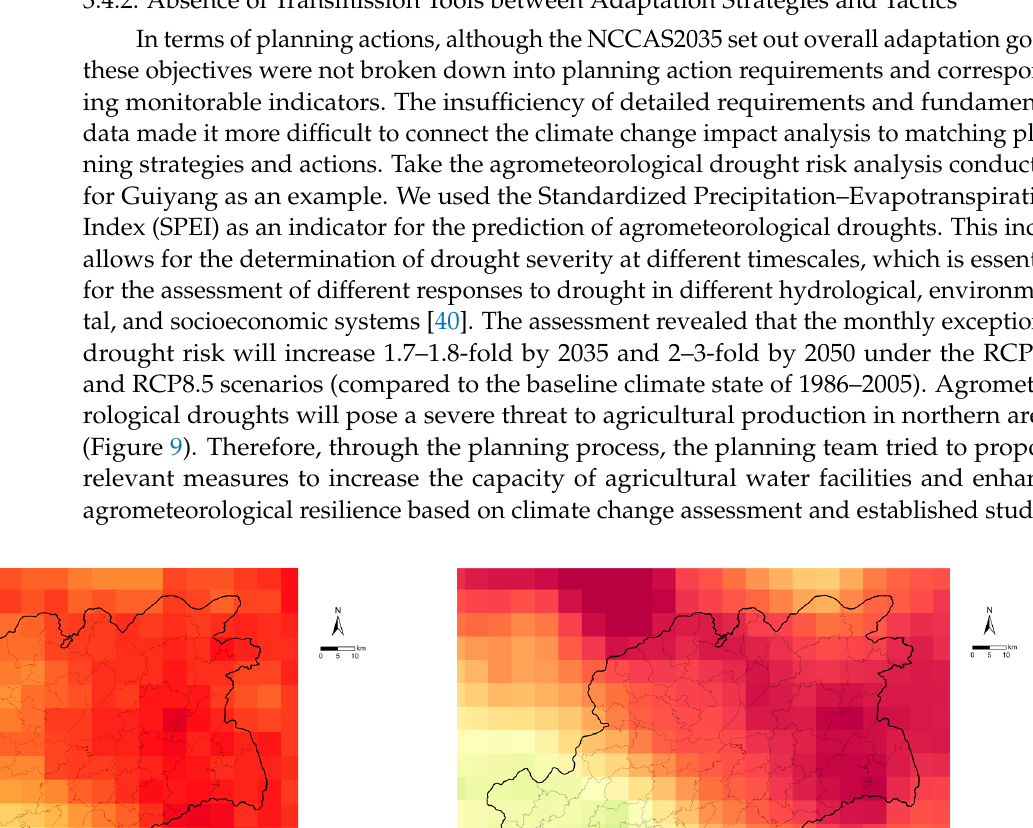
Table 1. Agrometeorological drought adaptation actions proposed in Guiyang MTSP. Region (County/District/City)